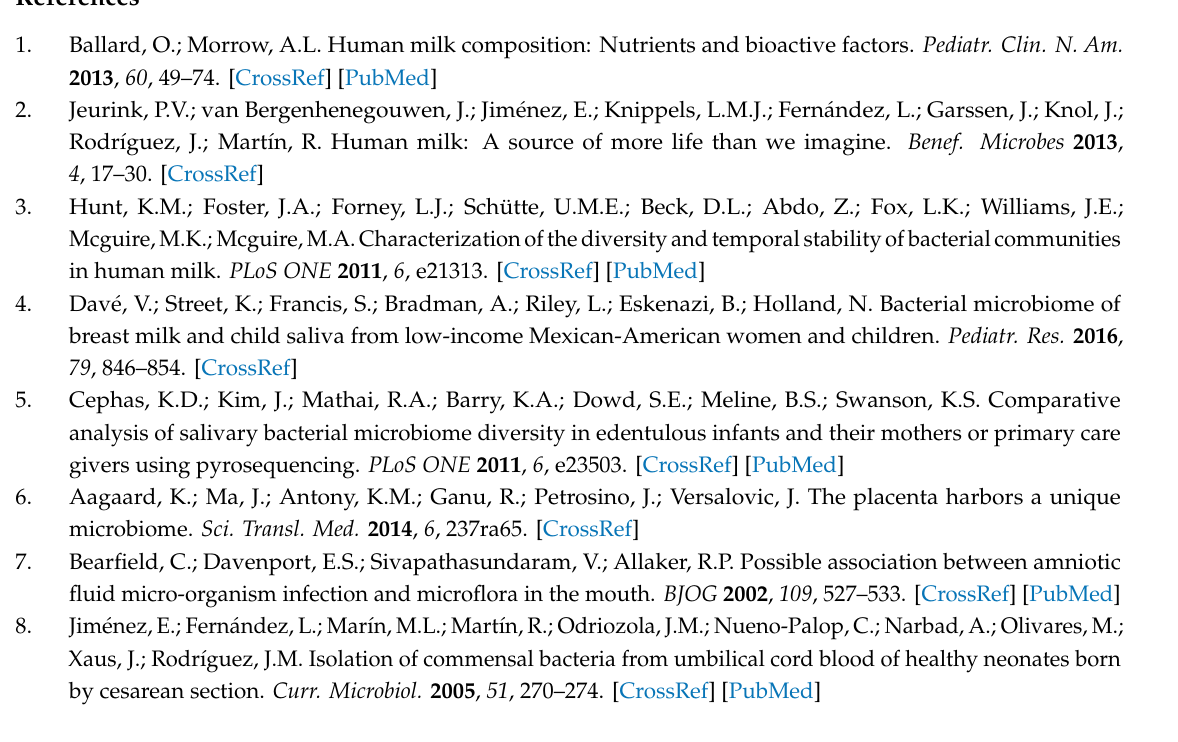
Table S1: Dietary information of infants at each time point, Table S2: Additional information of infants / mothers, and delivery complications, Table S3. Influence of feeding method on bacterial genera at birth (24 – 48 h after